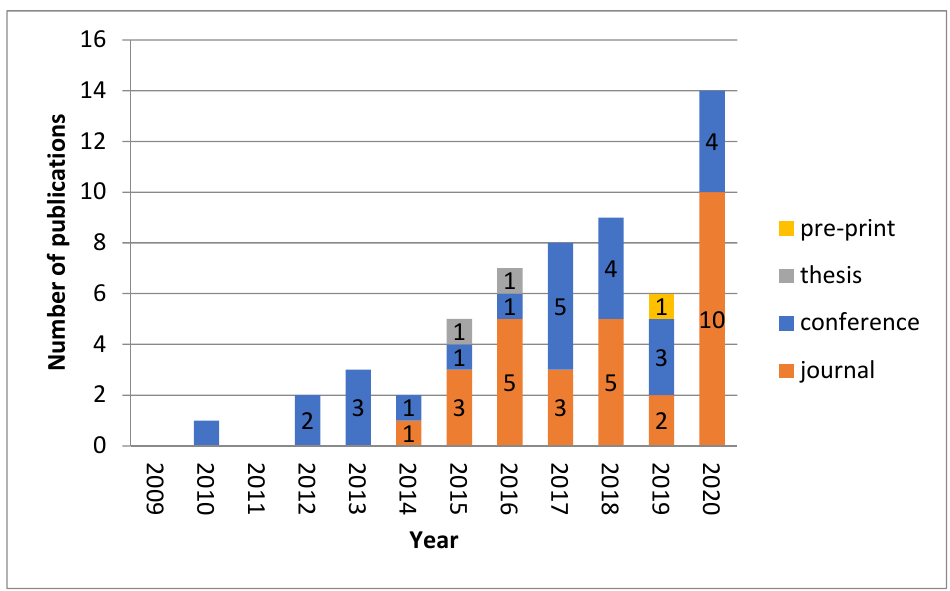
Figure 4. Temporal distribution of the selected publications.